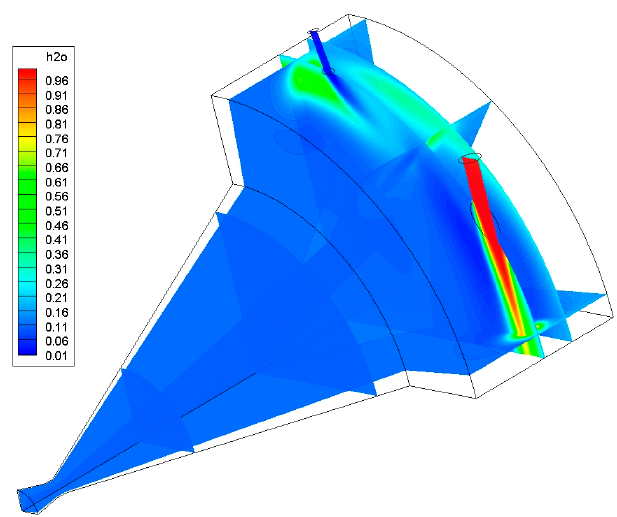
Figure 7. Hydrogen mass fraction distribution.